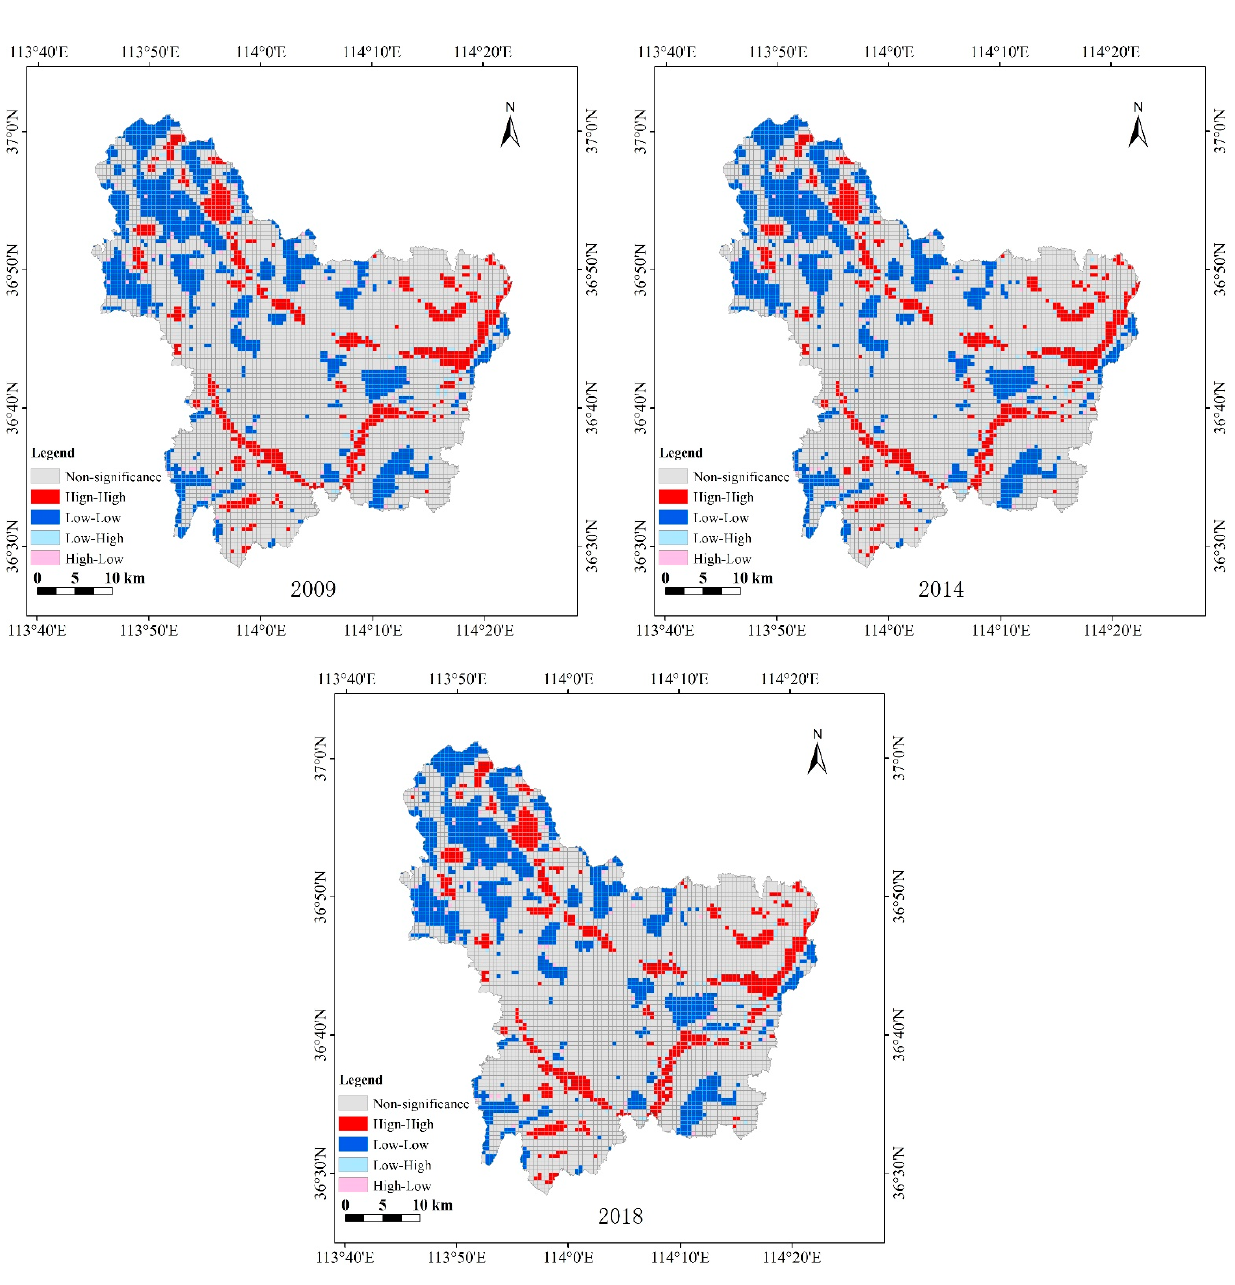
Figure 7. LISA aggregation diagrams.